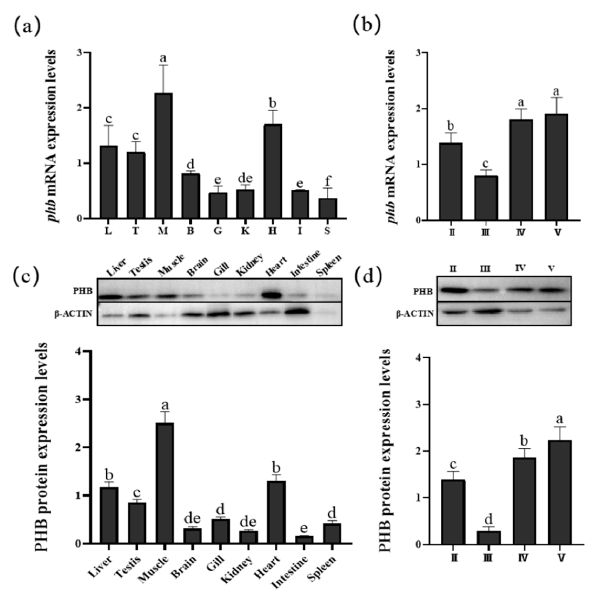
Figure 7. Expression pattern of phb mRNA and PHB protein. Expression pattern of phb mRNA and PHB protein in O. bidens in ( a , c ) various tissues and ( b , d ) in testes at stages II–V, as determined by WB and qPCR, with levels of β -actin as the positive control. I, III, IV, V indicate stages of testis development in O. bidens . L, T, M, B, G, K, H, I, and S indicate the liver, testis, muscle, brain, gill, kidney, heart, intestine, and spleen, respectively. The significance difference of data are represented by a–f. The same letter means that the difference is not significant ( p > 0.05), and the different letter means that the difference is significant ( p <